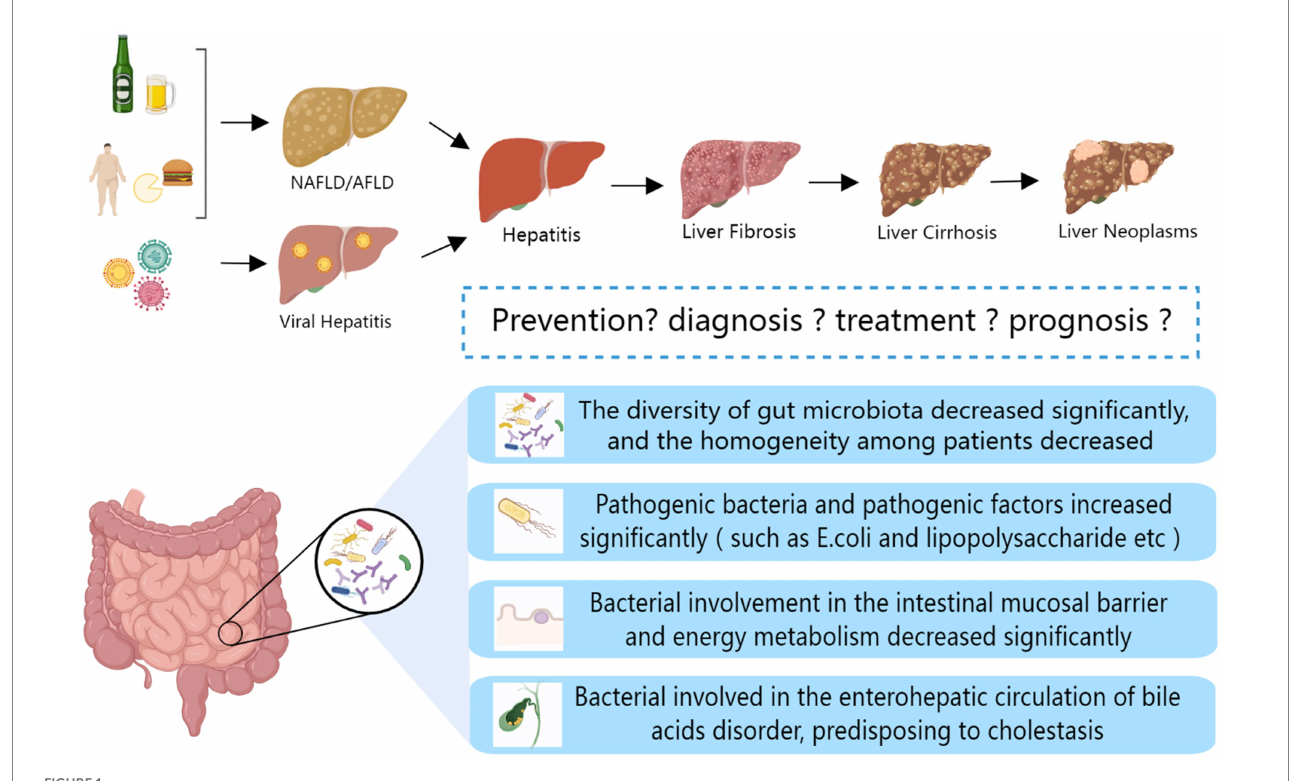
FIGURE 1 Changes in gut microbiota during liver disease